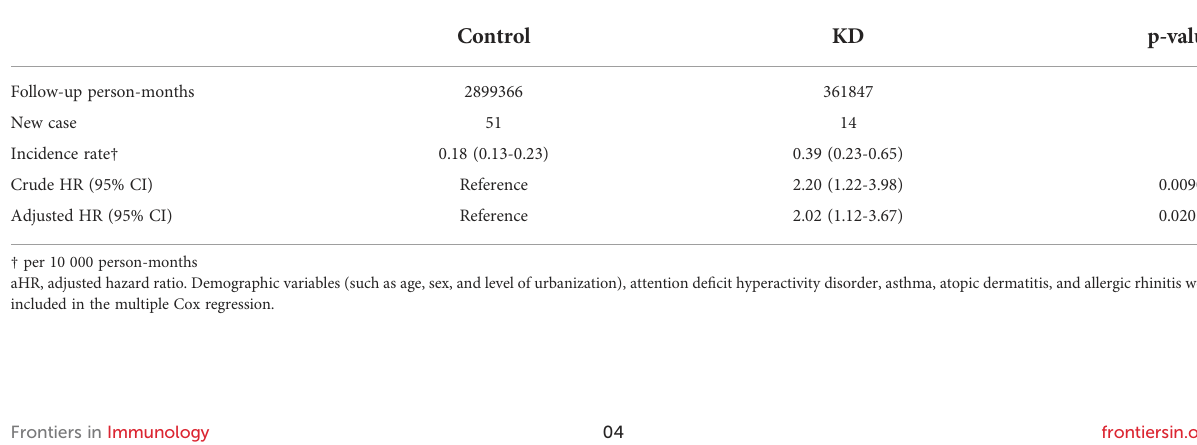
TABLE 2 Incidence of JIA .